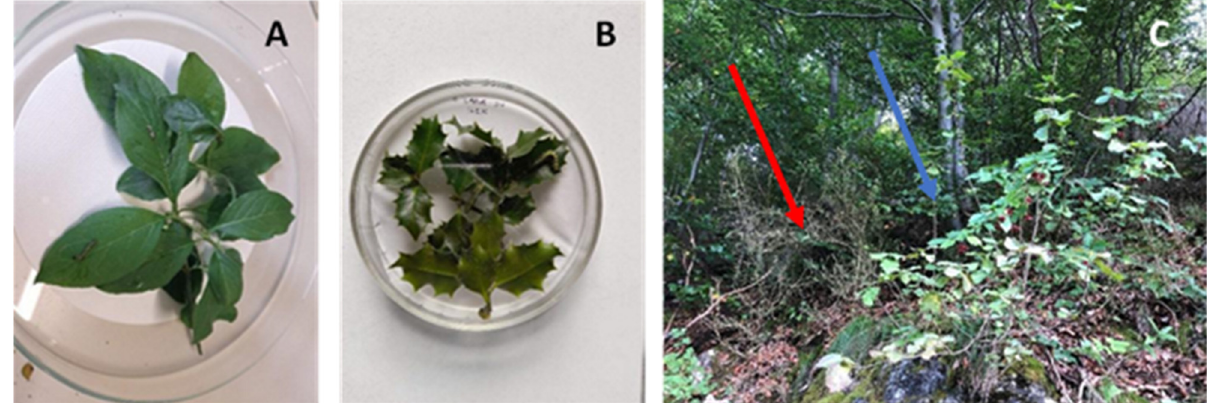
Figure 3. No-choice tests on Euonymus europaeus ( A ) and Ilex aquifolium ( B ) in controlled conditions and presence of healthy E. europaeus (blue arrow) located near Buxus sempervirens severely infested by Cydalima perspectalis (red arrow) in field conditions ( C ).